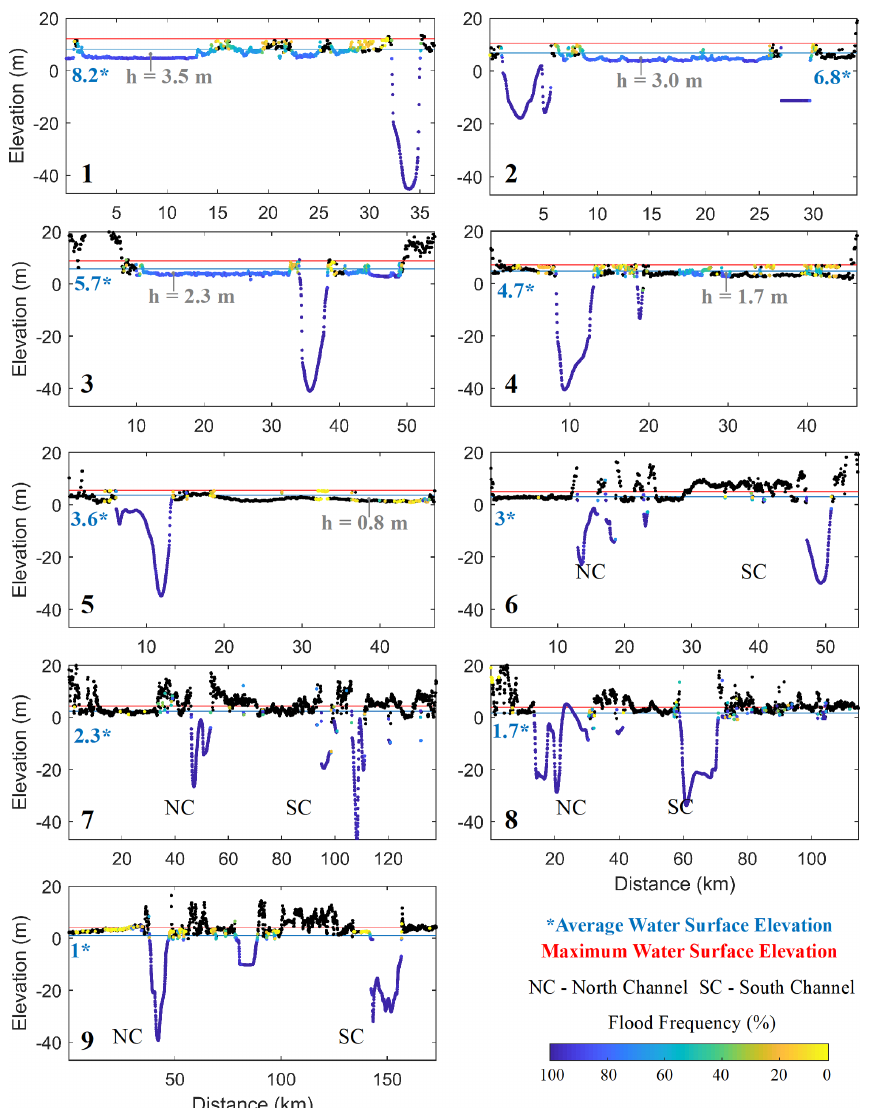
Figure 8. Topographic profiles distributed every 100km along the river, with the flood frequency, average and maximum WSE, and height between the average level and the minimum elevation of the